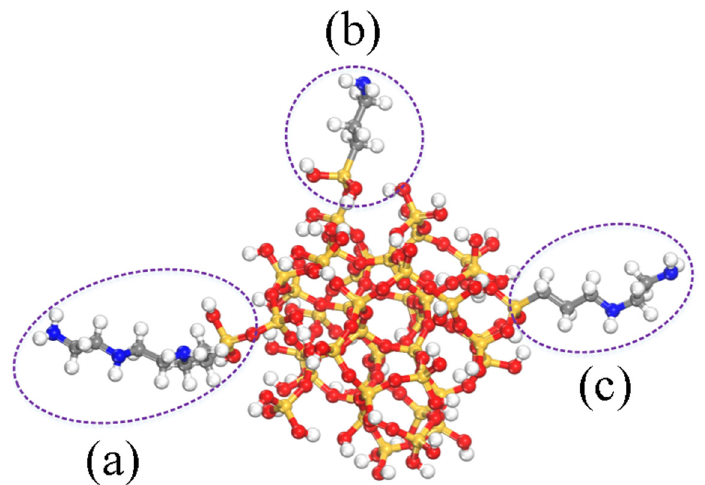
Figure 2. The three kinds of silane coupling agents grafted on the surface of nano-silica particles, ( a ) TAPS, ( b ) KH550, ( c ) KH792.